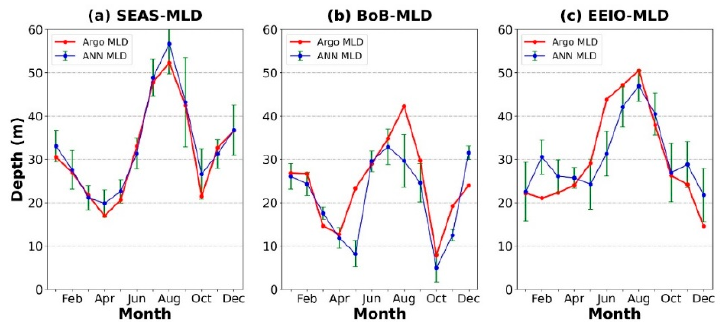
Figure 8. The monthly averaged MLD for the ( a ) SEAS, ( b ) BoB, and ( c ) EEIO in 2019. Error bars have been included for each ANN ‐ estimated MLD based upon the standard deviation.